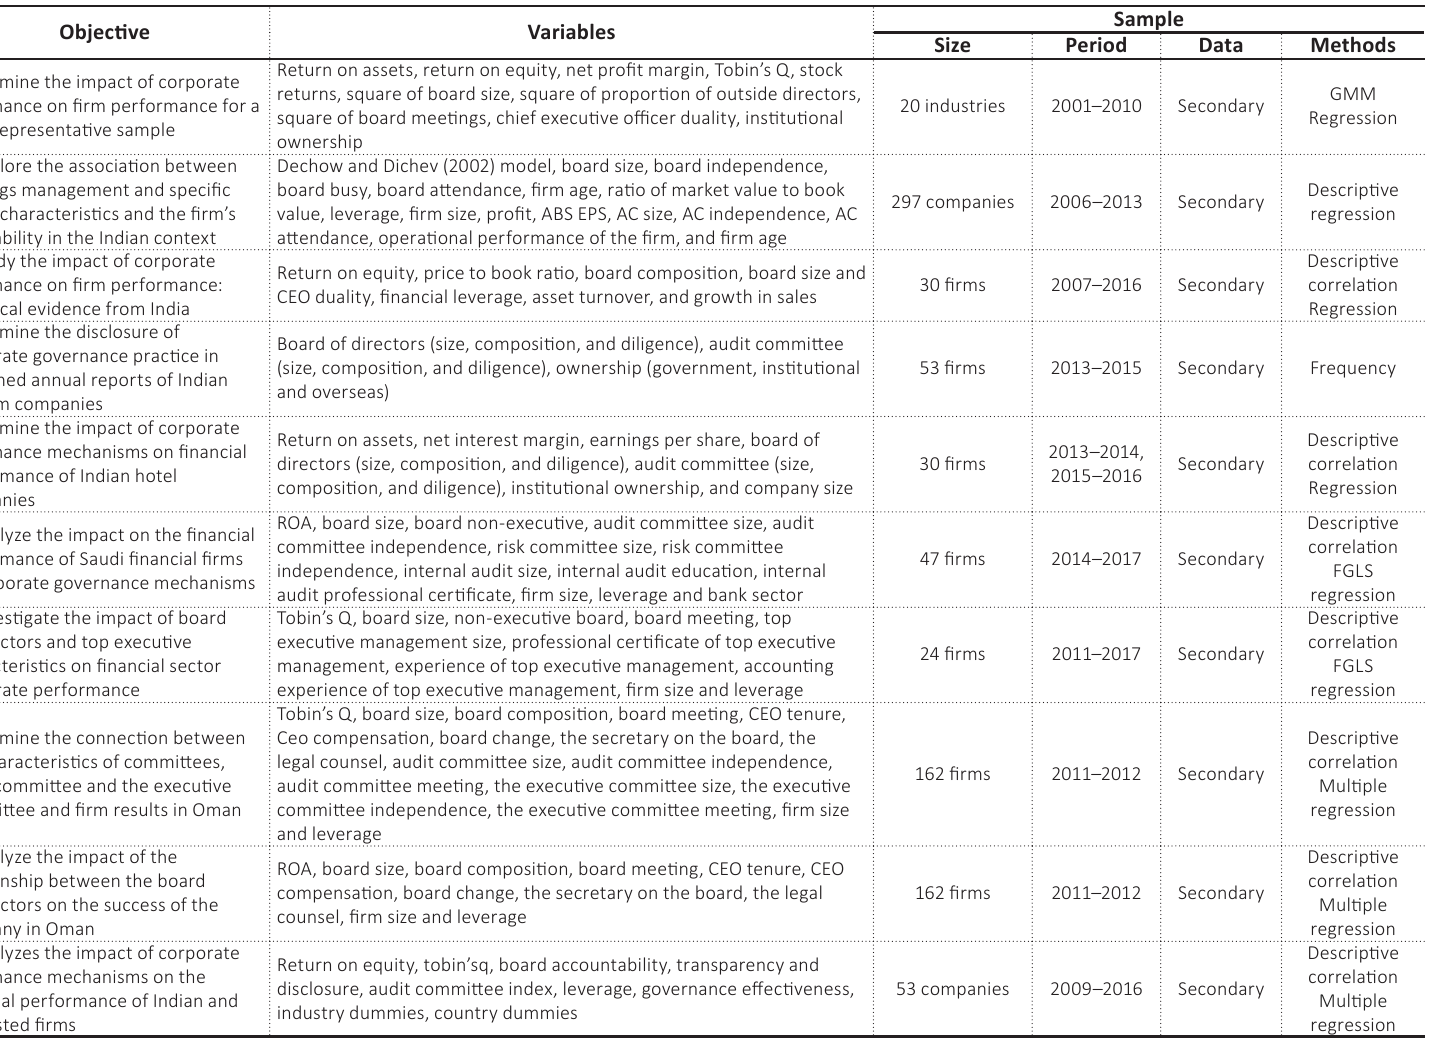
Table 1A (cont.). Some of prior studies in